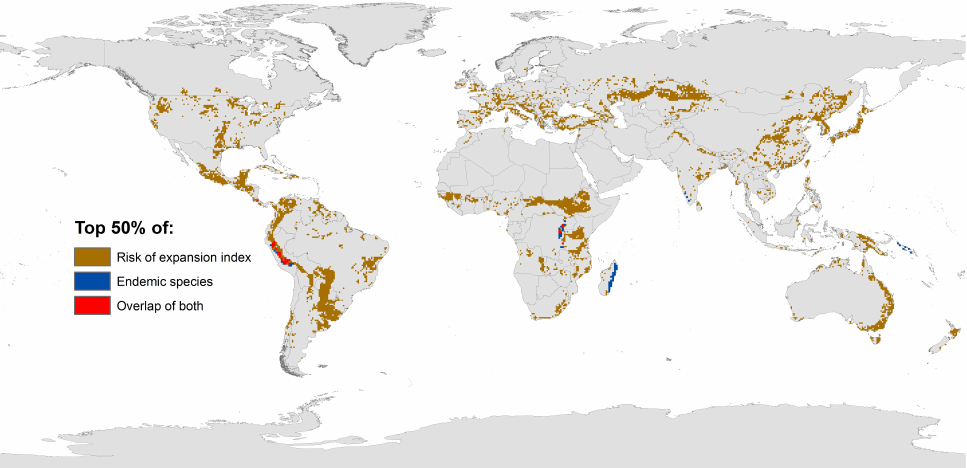
Figure 6. Overlay of endemic species richness and risk of expansion